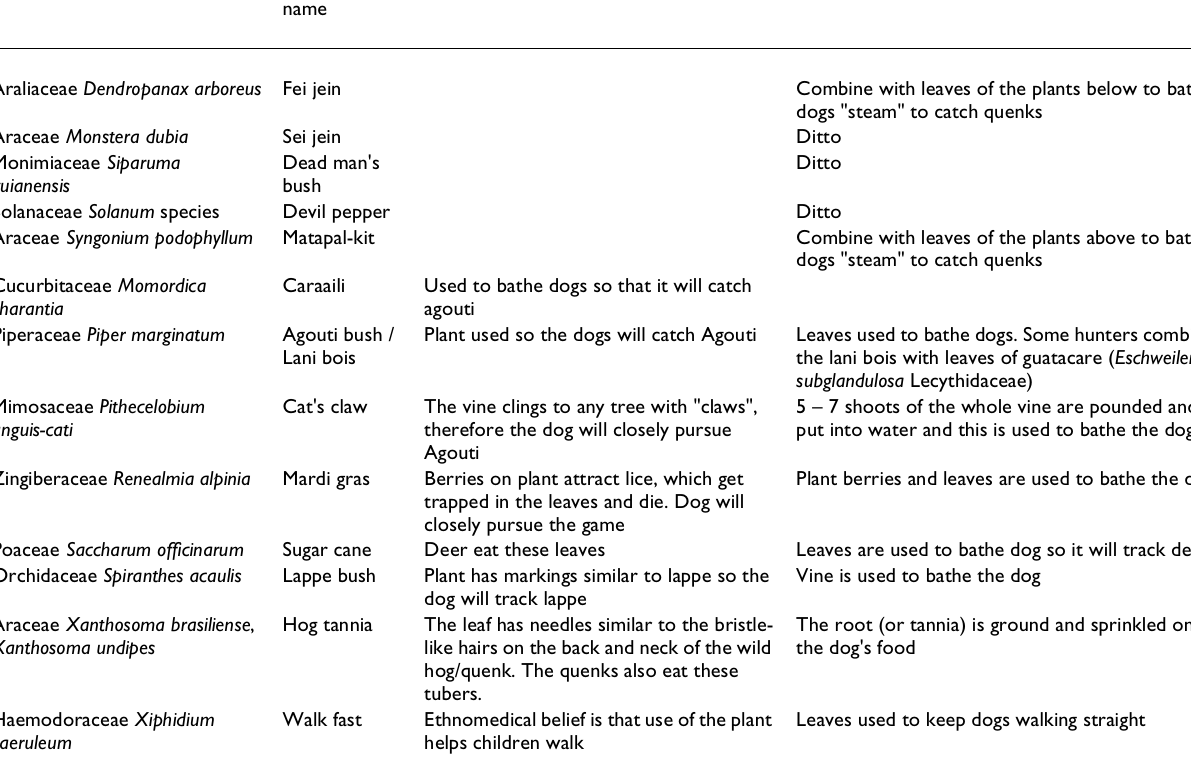
Table 2: Plants used for successful hunting (Doctrine of Signatures) Scientific